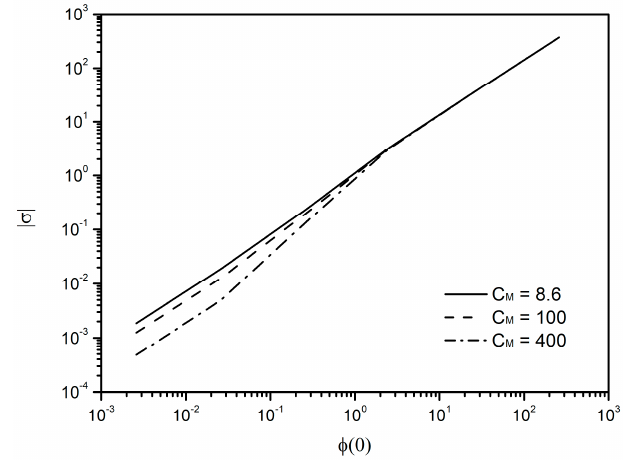
Figure 3. Surface charge density dependance on ϕ ( 0 ) at the outer Helmholtz plane for various C M .